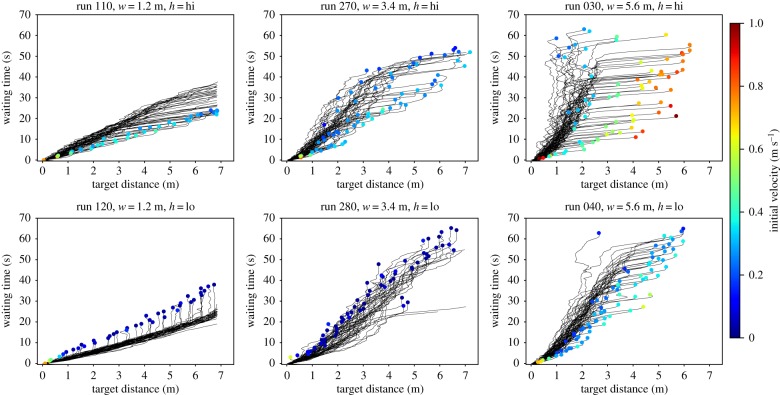
Individual waiting time versus target distance. The coordinates of the dots indicate the complete runtime and the initial distance to the target (see figure 1 for target location). The colour of the dots indicates the initial velocity within the first 4 s after the starting signal.